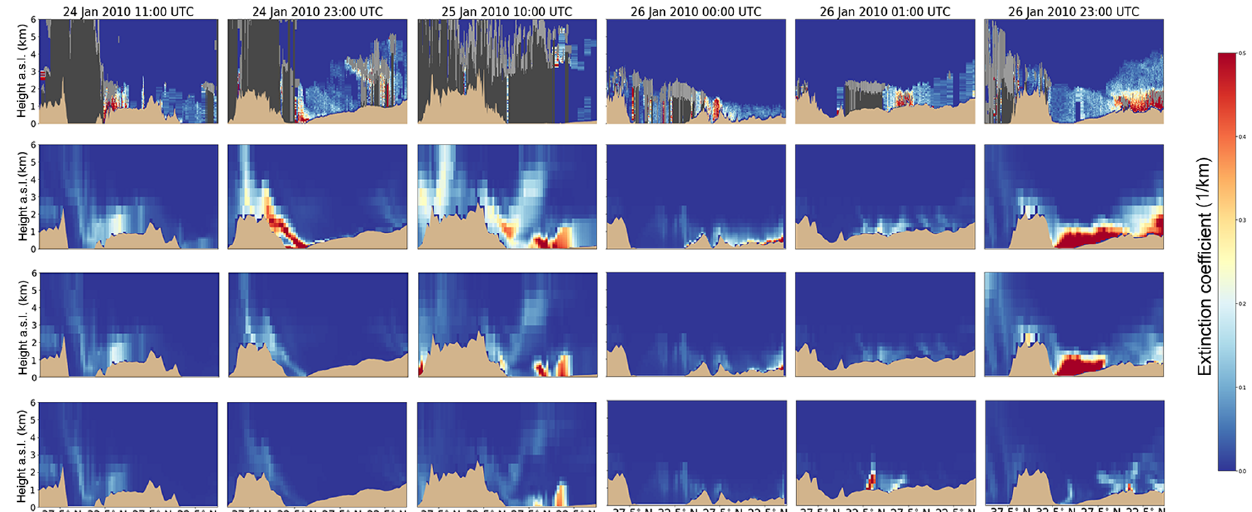
Figure 6. Aerosol extinction profiles at 550nm along the CALIOP transects for each of the six overpasses shown as integrated AOD in Fig. 5. Row 1 represents observed CALIOP data, with light gray indicating clouds, and dark gray indicating areas beneath clouds where no data are available. The remaining three rows represent modeled data, with GOCART-WRF in row 2, AFWA in row 3, and UoC in row